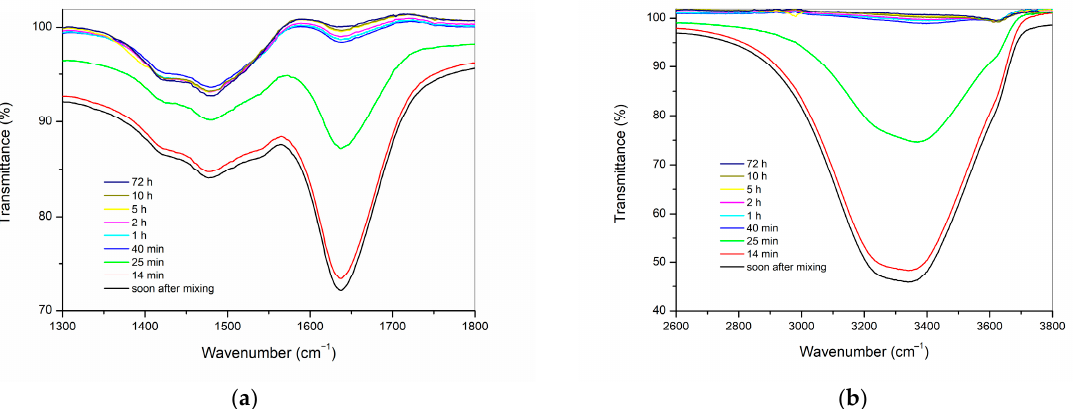
Figure 8. ATR-FTIR spectra of the RS+ paste at selected time intervals following mixing shown in the regions of: ( a ) 1300–1800 cm − 1 ; and ( b ) 2600–3800 cm − 1 .